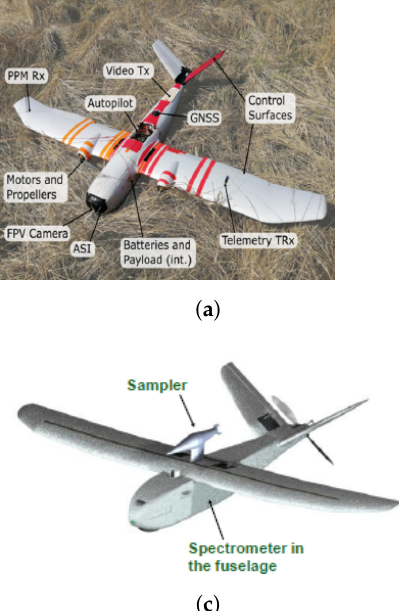
Figure 9. Examples of detection systems coupled to unmanned fixed-wing aircraft: ( a ) UAV with two SIGMA-50 CsI(Tl) scintillation detectors. Reproduced, with permission, from Reference [67]; published by Frontiers, 2020, under the terms of the https://creativecommons.org/licenses/by/4. 0/CC BY 4.0 license. ( b ) Ranger UAV with a GM, NaI(Tl) and a CZT detection system. Reproduced, with permission, from Reference [170]. ( c ) Patria MASS Mini UAV with a CsI detector (in the fuselage) a radioactive particle air sampler (on top). Reproduced, with permission, from Reference